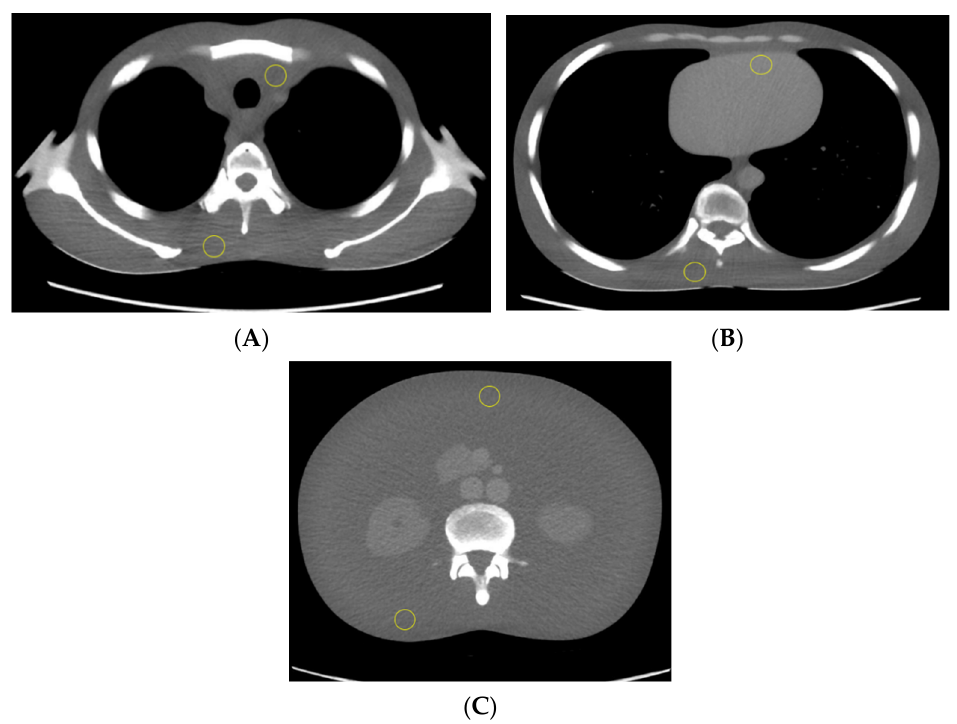
Figure 1. The phantom trunk is pictured supine with axial CT slices of the upper thorax ( A ), mid thorax ( B ), and abdomen ( C ). Two ROIs (yellow circle) were used to calculate the mean CT number measurements.